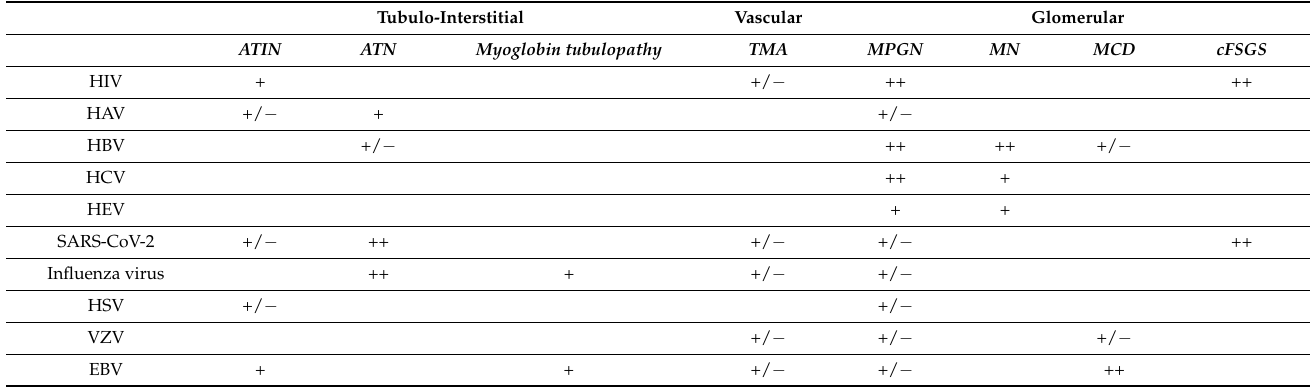
Table 1. General overview of histological patterns depicted in viral nephropathies. “+/ − “ refers to several cases reported, “+” refers to a rarely described association and “++” refers to a